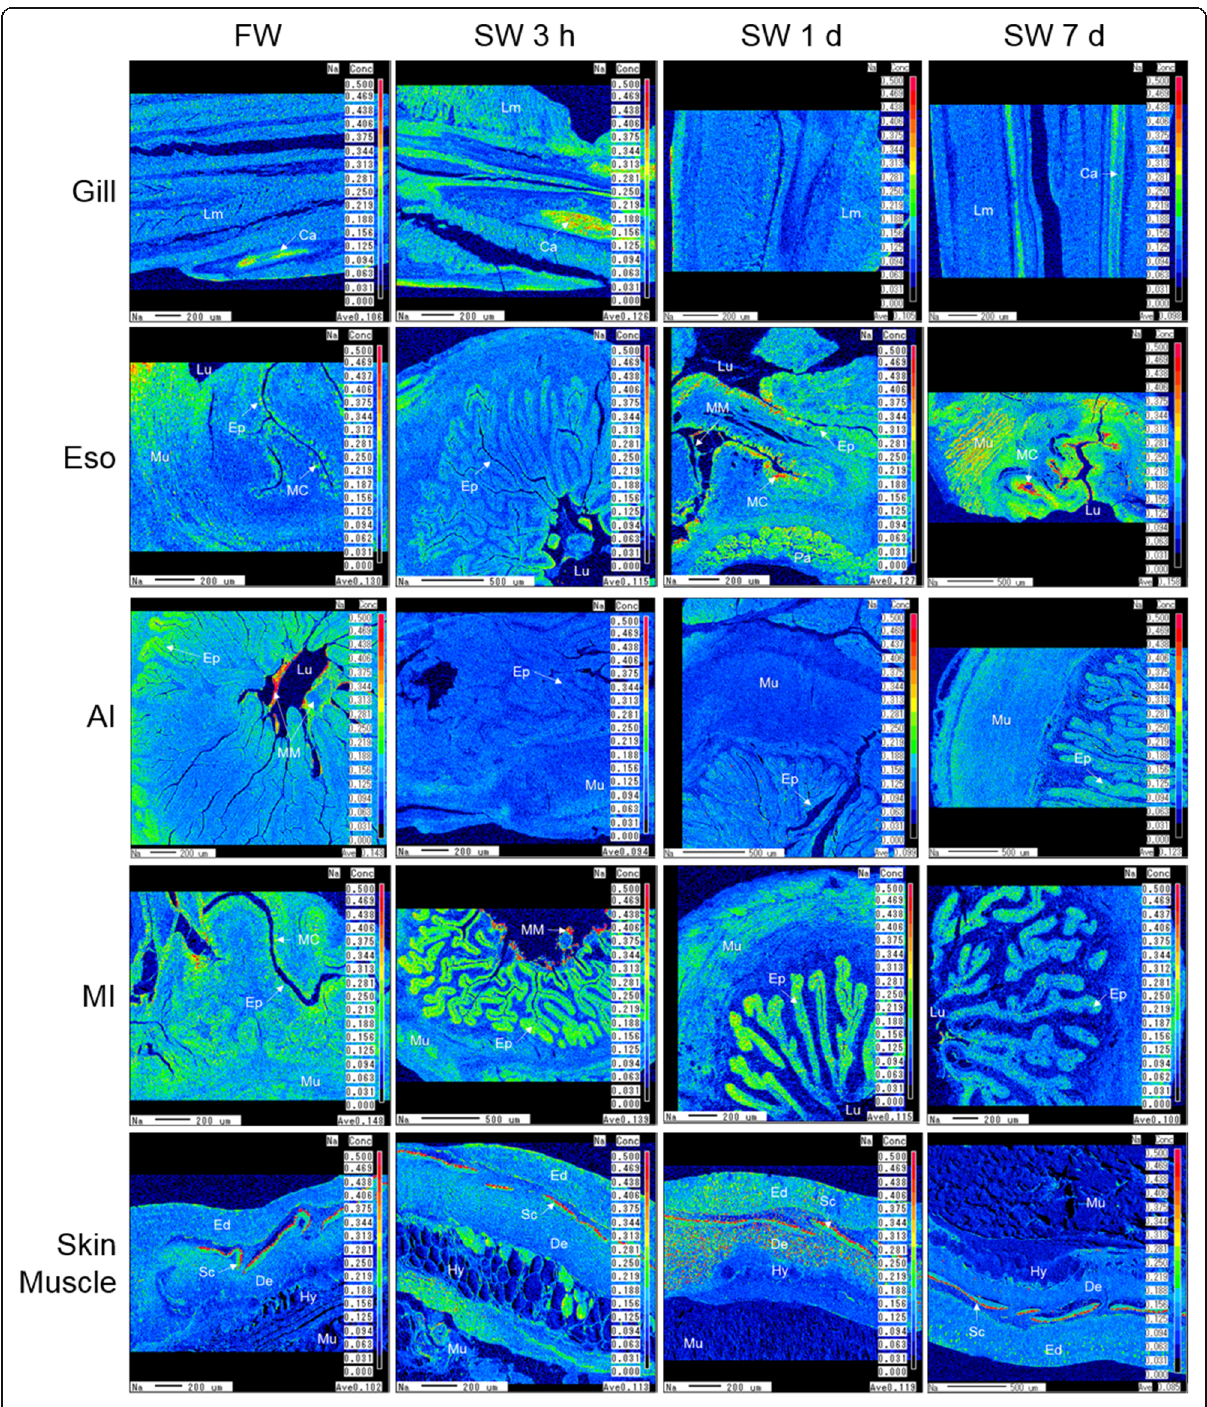
Fig. 6 Bound Na distribution in gill, esophagus (Eso), anterior intestine (AI), middle intestine (MI), and skin of eels acclimated to FW, SW 3 h, SW 1 d, or SW 7 d. Scale on the right shows the color gradient of Na concentration. Lm = lamellae; Ca = cartilage; Ep = luminal epithelium; Mu = muscle; MC = mucus cells; MM = mucus mass; Lu = lumen; Pa = pancreas; Ed = epidermis; De = dermis; Hy = hypodermis; Sc = sub-epidermal